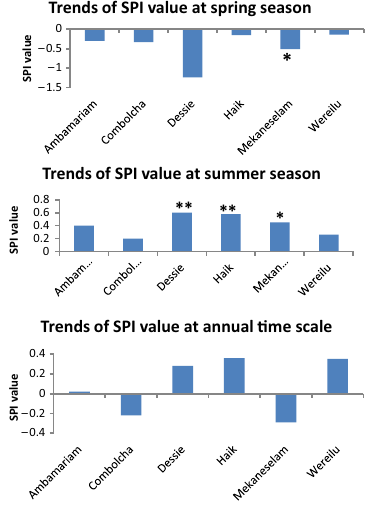
Figure 4. The Mann – Kendall ’